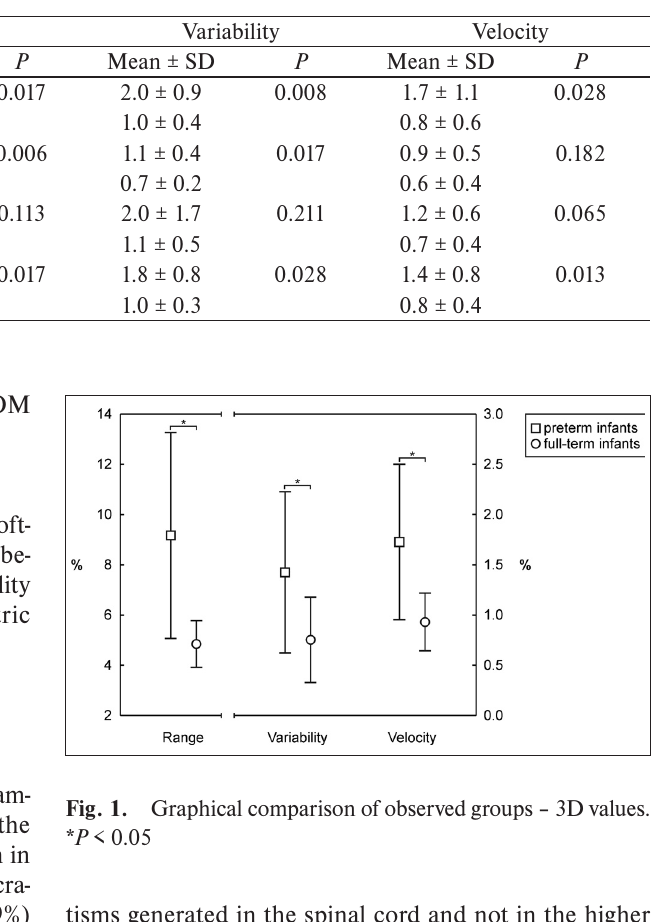
Table 2. Basic statistical characteristics of measured COM